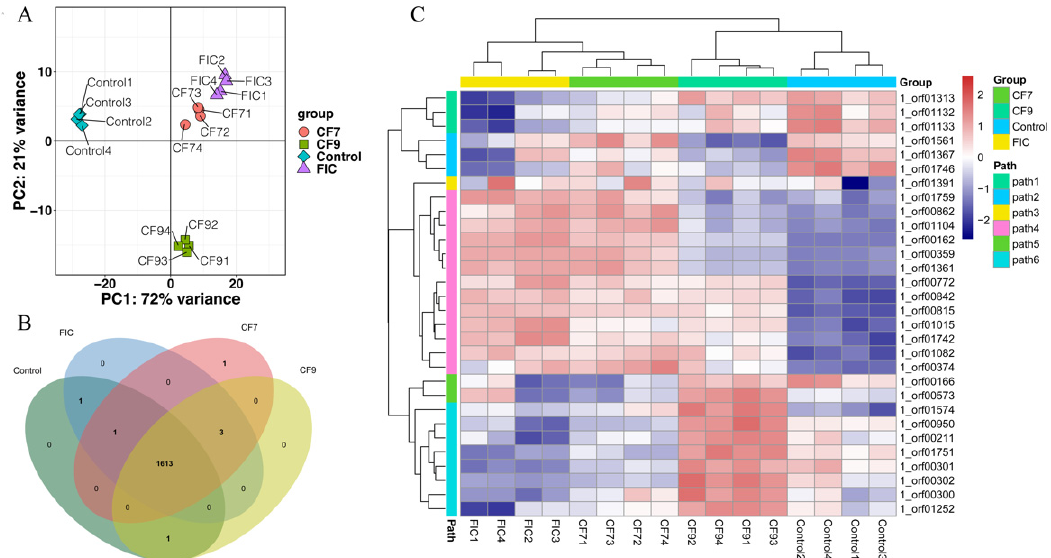
Figure 5. H. pylori 3192 biofilm transcriptome in different treatment groups. Principal component analysis (PCA) ( A ), Venn diagram ( B ), and heat map ( C ) showed the common and differently expressed genes in different treatment groups. Control group: BB2, FIC group: 1 × FIC of AMX and CLR, CF7 group: 6.25% CFS of 10 7 CFU/mL L. salivarus LN12 in combination with 1 × FIC of AMX and CLR, CF9 group: 6.25% CFS of 10 9 CFU/mL L. salivarus LN12 in combination with 1 × FIC of AMX and CLR. Four independent biological samples were used in every